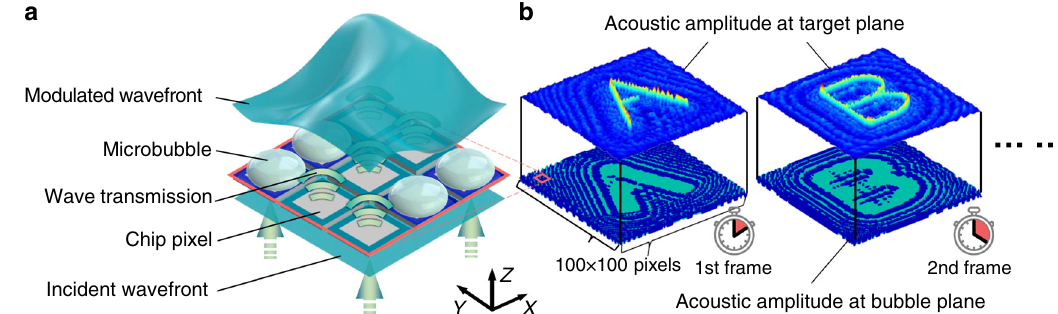
Fig. 1 Schematic of the spatial ultrasound modulation (SUM) based on microbubble patterns. a A microbubble can effectively block the acoustic transmission since its acoustic impedance differs signi fi cantly from the surrounding liquid. A pattern of microbubbles can therefore spatially modulate the incident plane acoustic wave and give it a complex wavefront. b The microbubble pattern encodes the binary amplitude kinoform (hologram) of the target acoustic fi eld. Refreshing the microbubble pattern enables dynamic spatial ultrasound